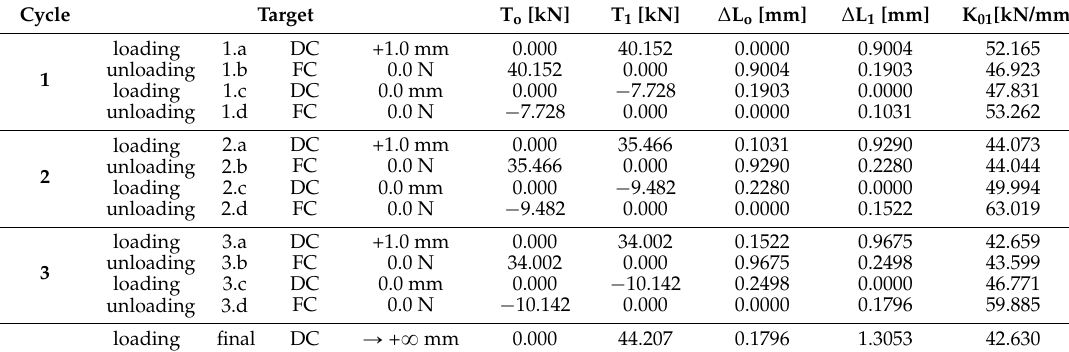
Figure 13. Multistep experimental procedure for the joint sample “II”. Table 7. Main test—joint sample